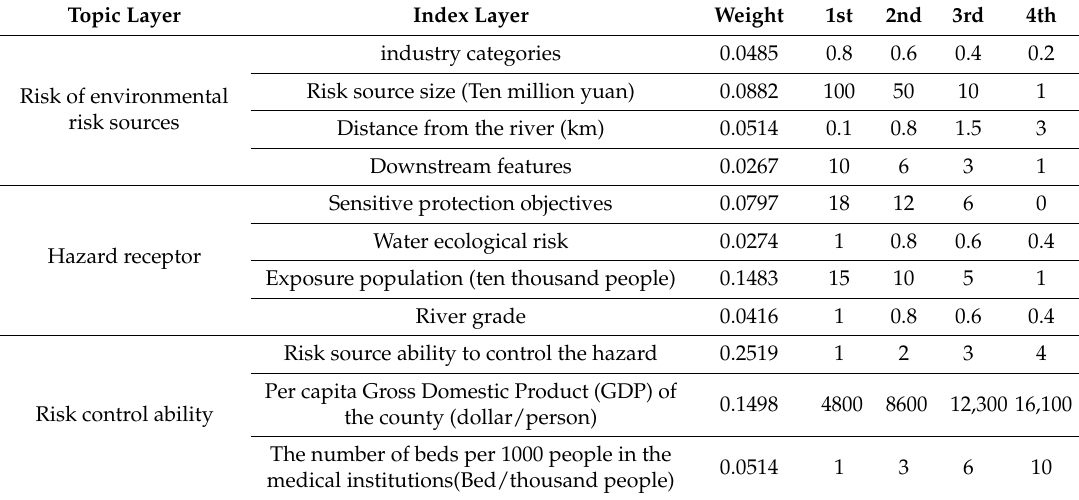
Table 2. Index classification standard and weight of the hazard